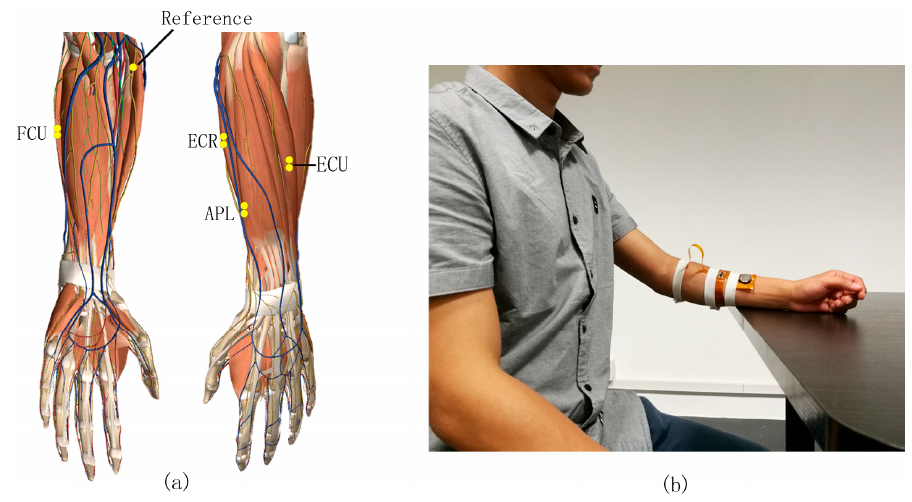
Figure 3. Sensor placement and implementation of the system. ( a ) Sensor placement in the offline analysis and the pairs of yellow points correspond to the bi-polar electrodes; ( b ) Real-time system setup for data acquisition.